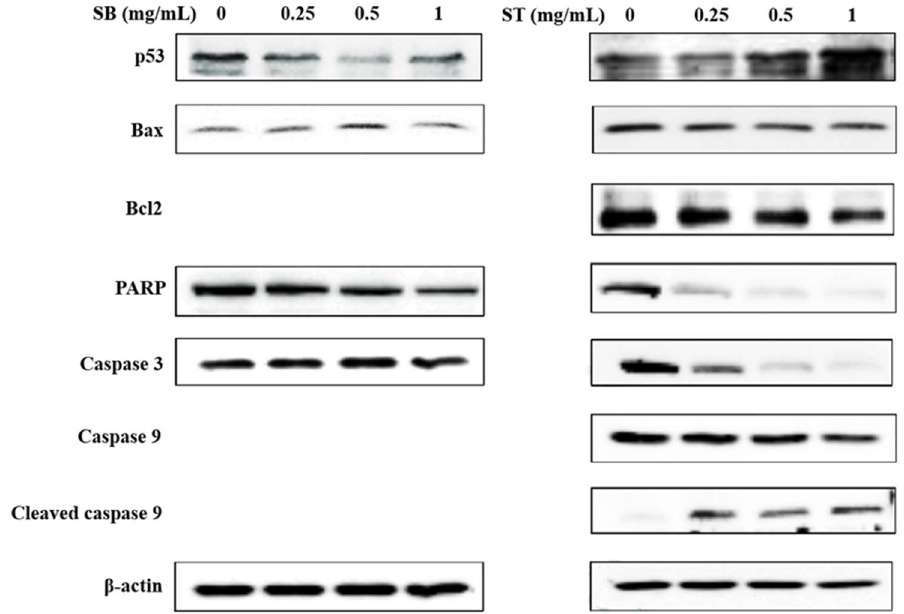
Figure 6. Effect of SB and ST on apoptosis-related protein levels in HSC-3 cells investigated by Western blot analysis. Cells were treated with 0.25, 0.5 and 1 mg/mL SB and ST for 72 h. β-Actin was used as a loading control. Figures show the representative blots from one of three experiments that gave similar results.